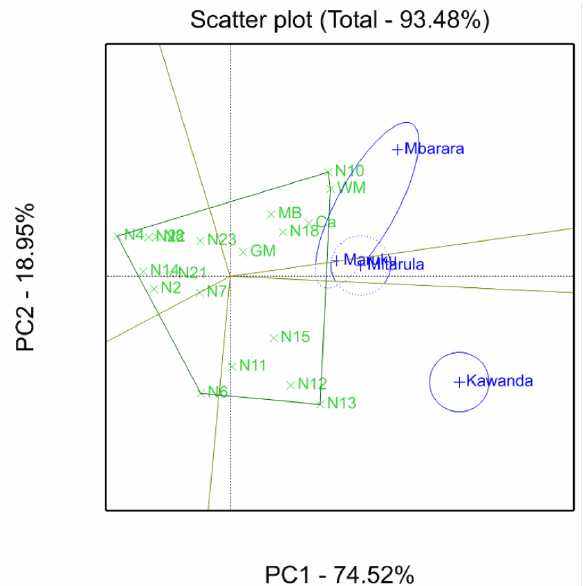
Figure 2. Polygon view of the genotype main effect and genotype x environment interaction biplot analysis for Sigatoka severity based on 19 banana cultivars evaluated in Uganda and Tanzania. Geno- types are given as codes (Matooke hybrids N—NARITA and banana varieties; MB—Mbwazirume, WM—Williams, Ca—Cachaco, GM—Gros Michel). Ranking of genotypes based on both the mean disease severity and stability perfor- mance identified 10 hybrids with low mean disease severity (Figure 3).